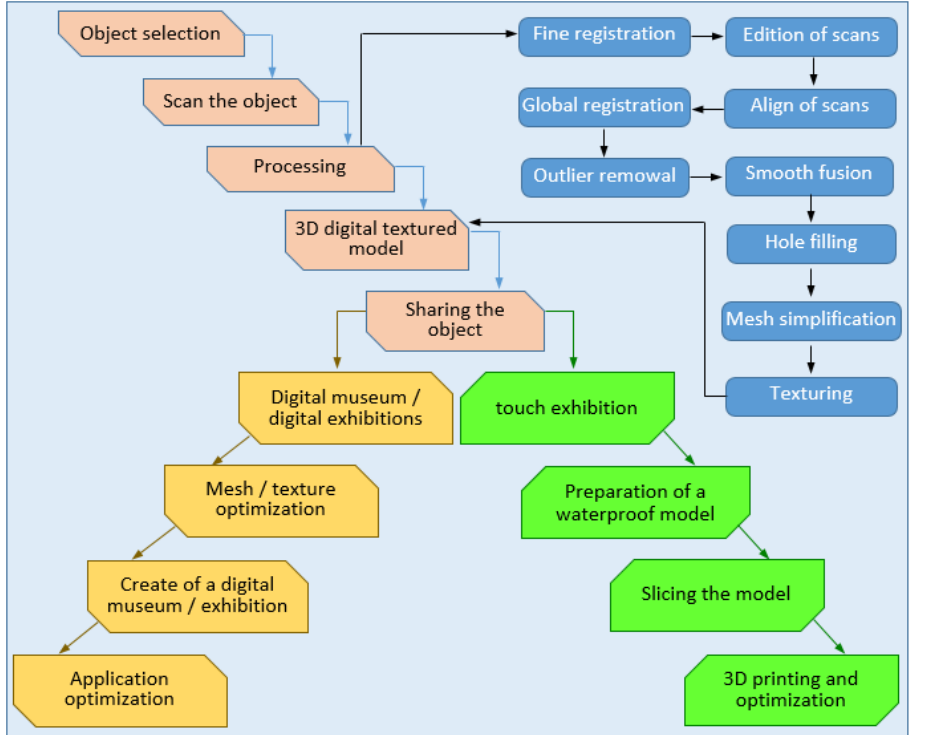
Figure 2. Procedure for making museum objects available.